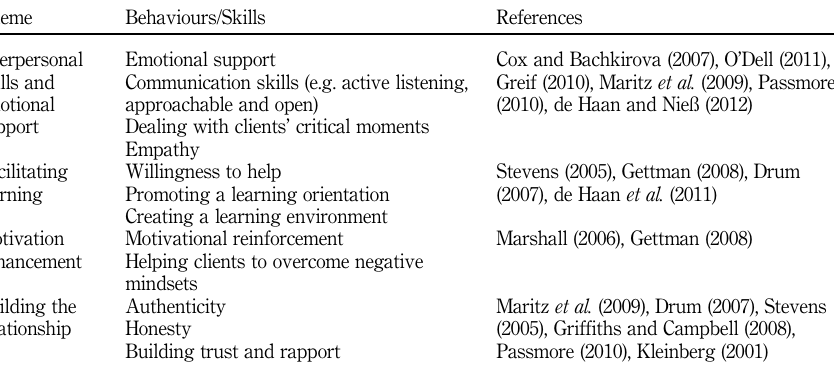
Table III. Essential effective